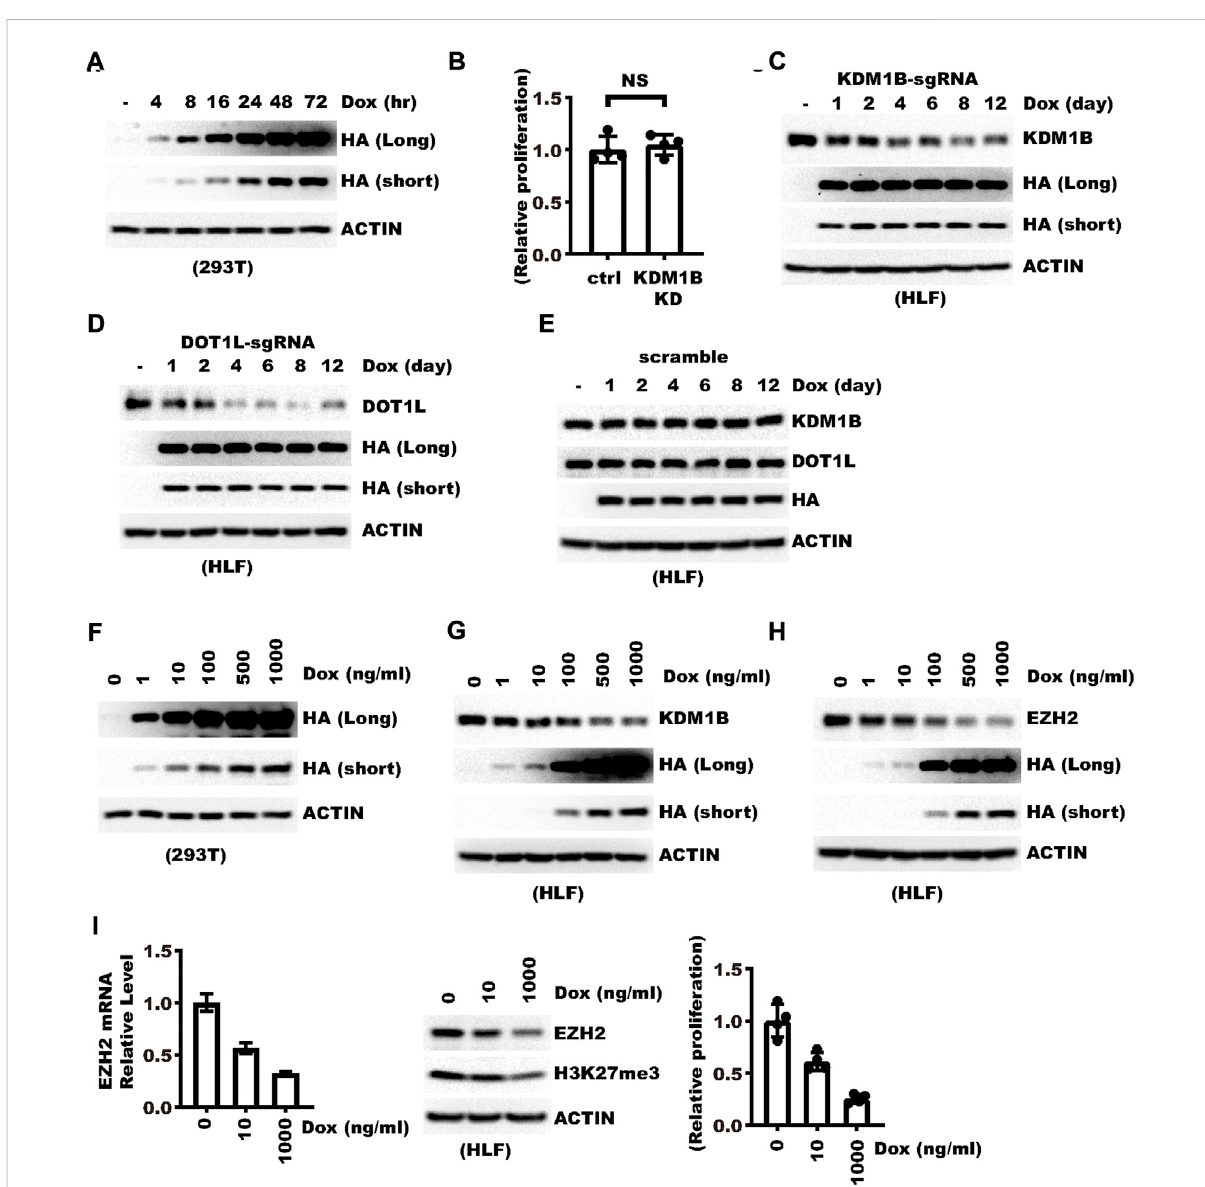
KnockdowncanbeinducedinaDoxycyclinedosage-dependentmanner. (A) 293TcellsweretransfectedwithpLenti-TRE-CasRx-scram. Cells were treated with 1 μ g/ml Doxycycline 24 h hours later for the indicated time. Shown are WB results. (B) Ctrl or KDM1B-knockdown (KD) cells were seededintoa6-wellplate.Knockdownwasinducedwith1 μ g/mldoxycycline.Shownistherelativecellproliferationduring7 daysnormalizedtothe control (Ctrl) group. “ NS ” denotes “ not signi fi cant ” as examined with a two-sided unpaired Welch ’ s t-test. (C) HLF cells were transduced with a virus expressing pLenti-TRE-CasRx-KDM1B-sgRNA. Cells were then selected with 1 μ g/ml puromycin for 5 days and treated with 1 μ g/ml Doxycycline for different times. Shown are the WB results. (D) HLF cells were transduced with a virus expressing pLenti-TRE-CasRx-DOT1L-sgRNA. Cells were then selected with 1 μ g/ml puromycin for 5 days and treated with 1 μ g/ml Doxycycline for different times. Shown are the WB results. (E) HLF cells were transduced with a virus expressing pLenti-TRE-CasRx-scramble. Cells were then selected with 1 μ g/ml puromycin for 5 days. Afterward, cells were treated with 1 μ g/ml Doxycycline for different times. Shown are WB results. (F) 293 T cells were transfected with a virus expressingpLenti-TRE-CasRx-scram. 24 hlater,cellsweretreatedfor48 hwithDoxycyclineatdifferentdosages.ShownaretheWBresults. (G) HLF cells were transduced with a virus expressing pLenti-TRE-CasRx-KDM1B-sgRNA. Cells were then selected with 1 μ g/ml puromycin for 5 days. Afterward, cells were treated with Doxycycline for 4 days at different dosages. Shown are WB results. (H) HLF cells were transduced with a virus expressing pLenti-TRE-CasRx-EZH2-sgRNA. Cells were then selected with 1 μ g/ml puromycin for 5 days. Afterward, cells were treated with Doxycycline for 4 days at different dosages. Shown are WB results. (I) HLF cells were transduced with a virus expressing pLenti-TRE-CasRx-EZH2- sgRNA. Cells were then selected with 1 μ g/ml puromycin for 5 days. Afterward, the cells were treated with Doxycycline for 4 days at different dosages. Theleftpanel showstherelativemRNAlevelofEZH2.The middlepanel shows theWBresults. Therightpanel showstherelativefoldofcell